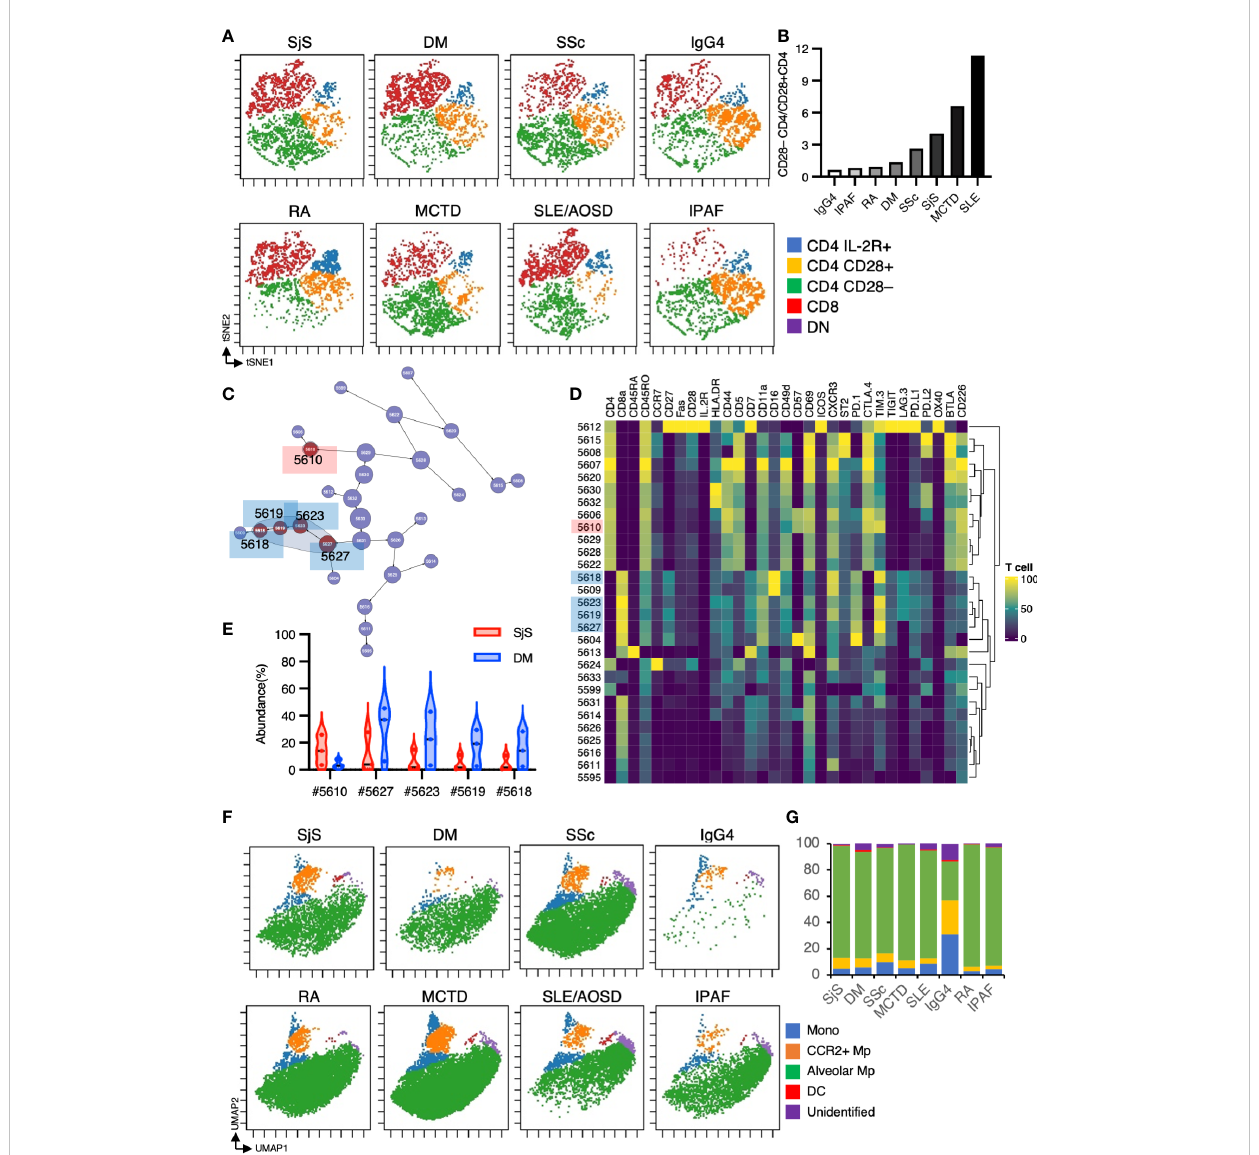
FIGURE 7 Immunological phenotypes in BALF cells from patients with CTD-ILD. (A) t-SNE plots visualizing the distribution of T cell subpopulations in BALF T cells (gated as CD45 + CD2 + CD3 + ) from patients with CTD-ILD. DN: CD4 – CD8 – double negative T cells. (B) The ratio of CD28 – CD4 T cells/CD28 + CD4 T cells de fi ned in t-SNE plots in each disease. (C) The Citrus network tree displays the hierarchical relationship and intensity of each marker among the T-cell populations in BALF from Sjogren syndrome-related ILD (n = 3) and dermatomyositis associated-ILD (n = 3). (D) Heatmap illustrating the expression markers across different clusters of T cells as determined by the Citrus analysis. (E) Citrus-generated violin plots for fi ve representative and differentially regulated populations. Each cluster number (C#) corresponds to the number shown in panel (C) . All differences in abundance are signi fi cant at a false discovery rate < 0.01. (F) UMAP plots visualizing the distribution of CD11b + CD11c + myeloid cell subpopulations in BALF from patients with CTD-ILD. Monocytes are de fi ned by CD64 + CD14 + , CCR2 + macrophages (Mp) by CCR2 + CD64 + CD14 – , Alveolar Mp